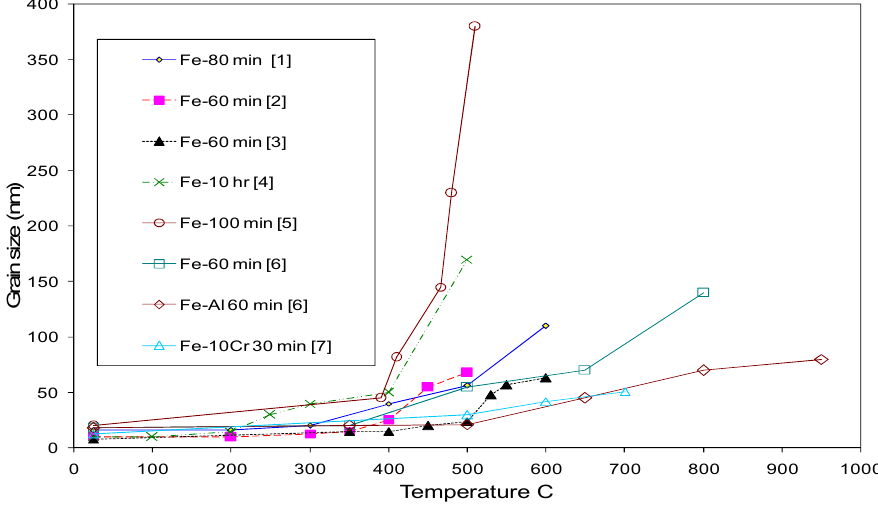
Figure 4. Grain growth data in literature for ball-milled nanocrystalline Fe and two Fe-alloy powders during annealing at different temperatures for different durations: [1] NanoStructured Materials, 6 (1995) 421 (Ref [25]), [2] NanoStructured Materials, 12 (1999) 685 (Ref [26]), [3] Acta Mater, 45 (1997) 2177 (Ref [23]), [4] Progress in Materials Science, 33 (1989) 223 (Ref [9]), [5] Mater. Sci. Forum, 343 (2000) 683 (Ref [27]), [6] NanoStructured Materials 9 (1997) 71 (Ref [28]), and [7] Mater Sci Engineering-A, 494 (2008) 253 (Ref [24]).